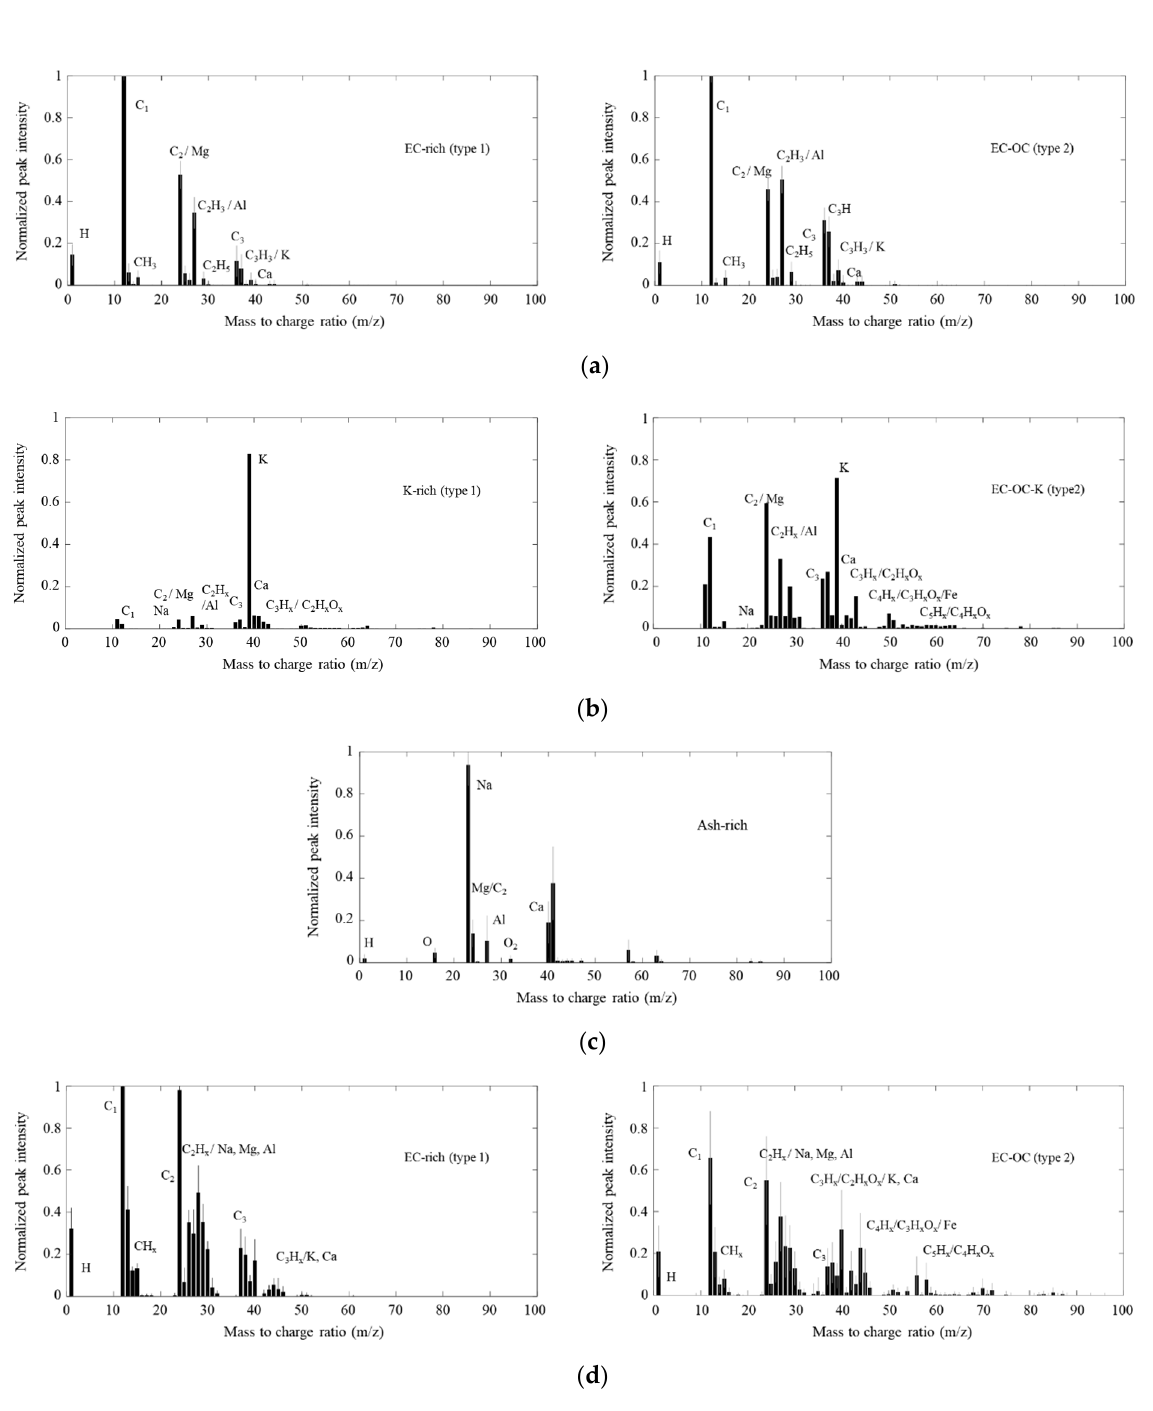
( d ) Figure 5. Particle number size distributions for various combustion aerosols (( a ) diesel engine, ( b ) rice straw burning, ( c ) coal burning, and ( d ) pork burning). The single-particle mass spectra obtained from the SPMS were classified by the K- means algorithm. Two major particle types were identified in diesel engine exhaust, as shown in Figure 6a. The EC-rich particles mostly consisted of elemental carbon (EC) (C 1 ,